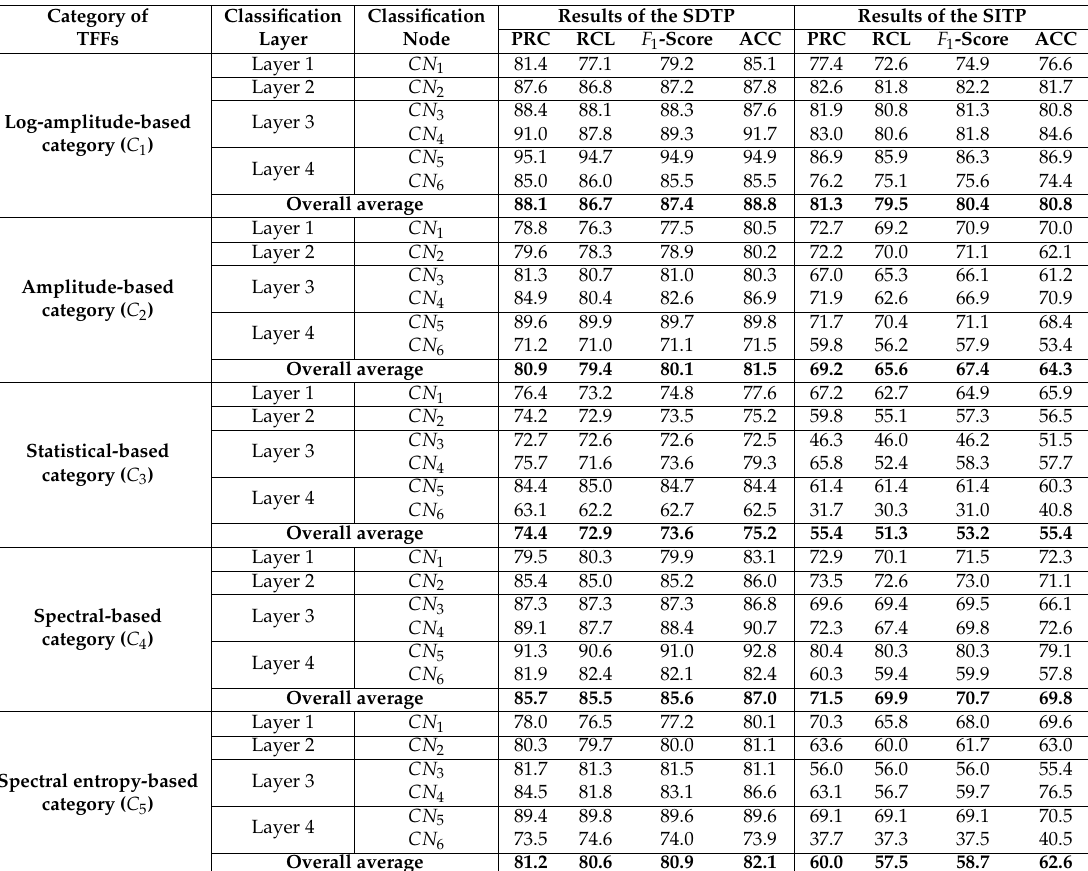
Table 4. Results of the TFF-based analysis obtained using the SDTP and SITP for the intact subjects in DB 1